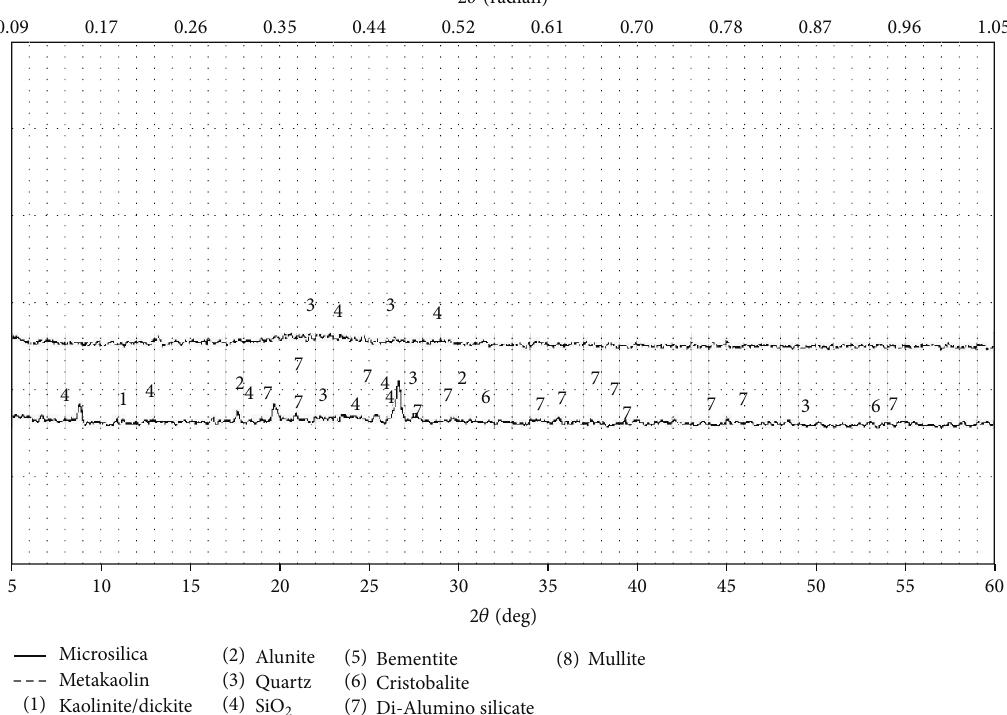
Figure 1: X-ray diffraction (XRD) spectrum of the silica fume and metakaolin.